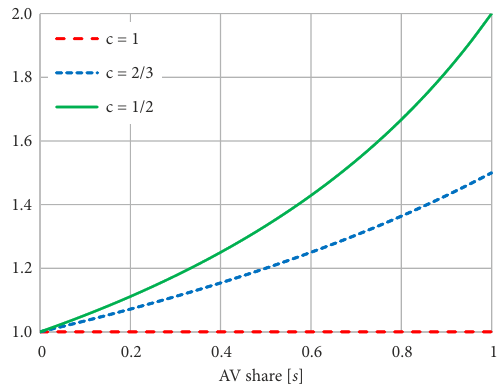
Figure 1. CDV and AV traffic dynamics in the adjusted queue model for two links at different times (the upper part shows only CDVs traversing the link, whereas the lower part includes both CDVs and AVs resulting in an increased throughput; in this example, an AV consumes only half the flow capacity a